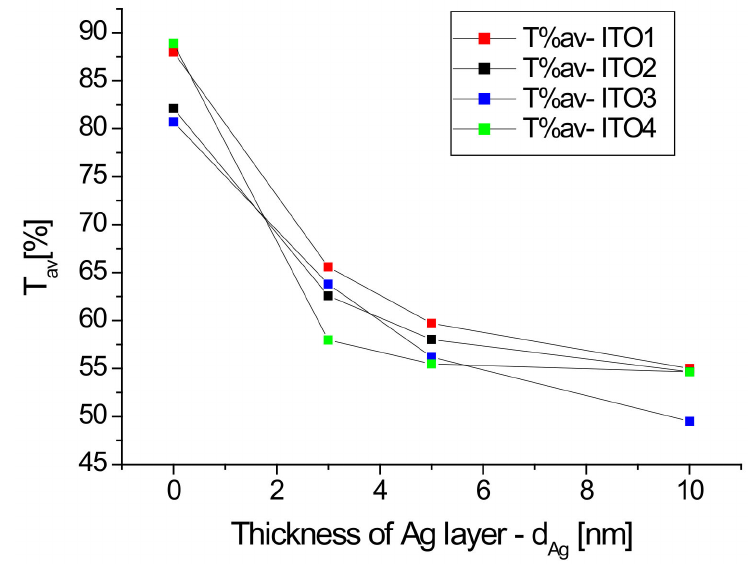
Figure 2. Dependence of average transmission in the visible region as a function of the Ag nanoparti- cle layer